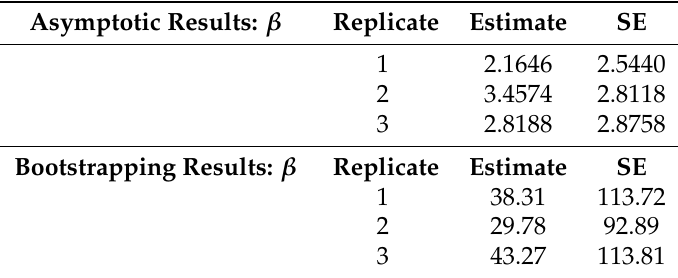
Table 3. β estimate and standard error for the Bernoulli